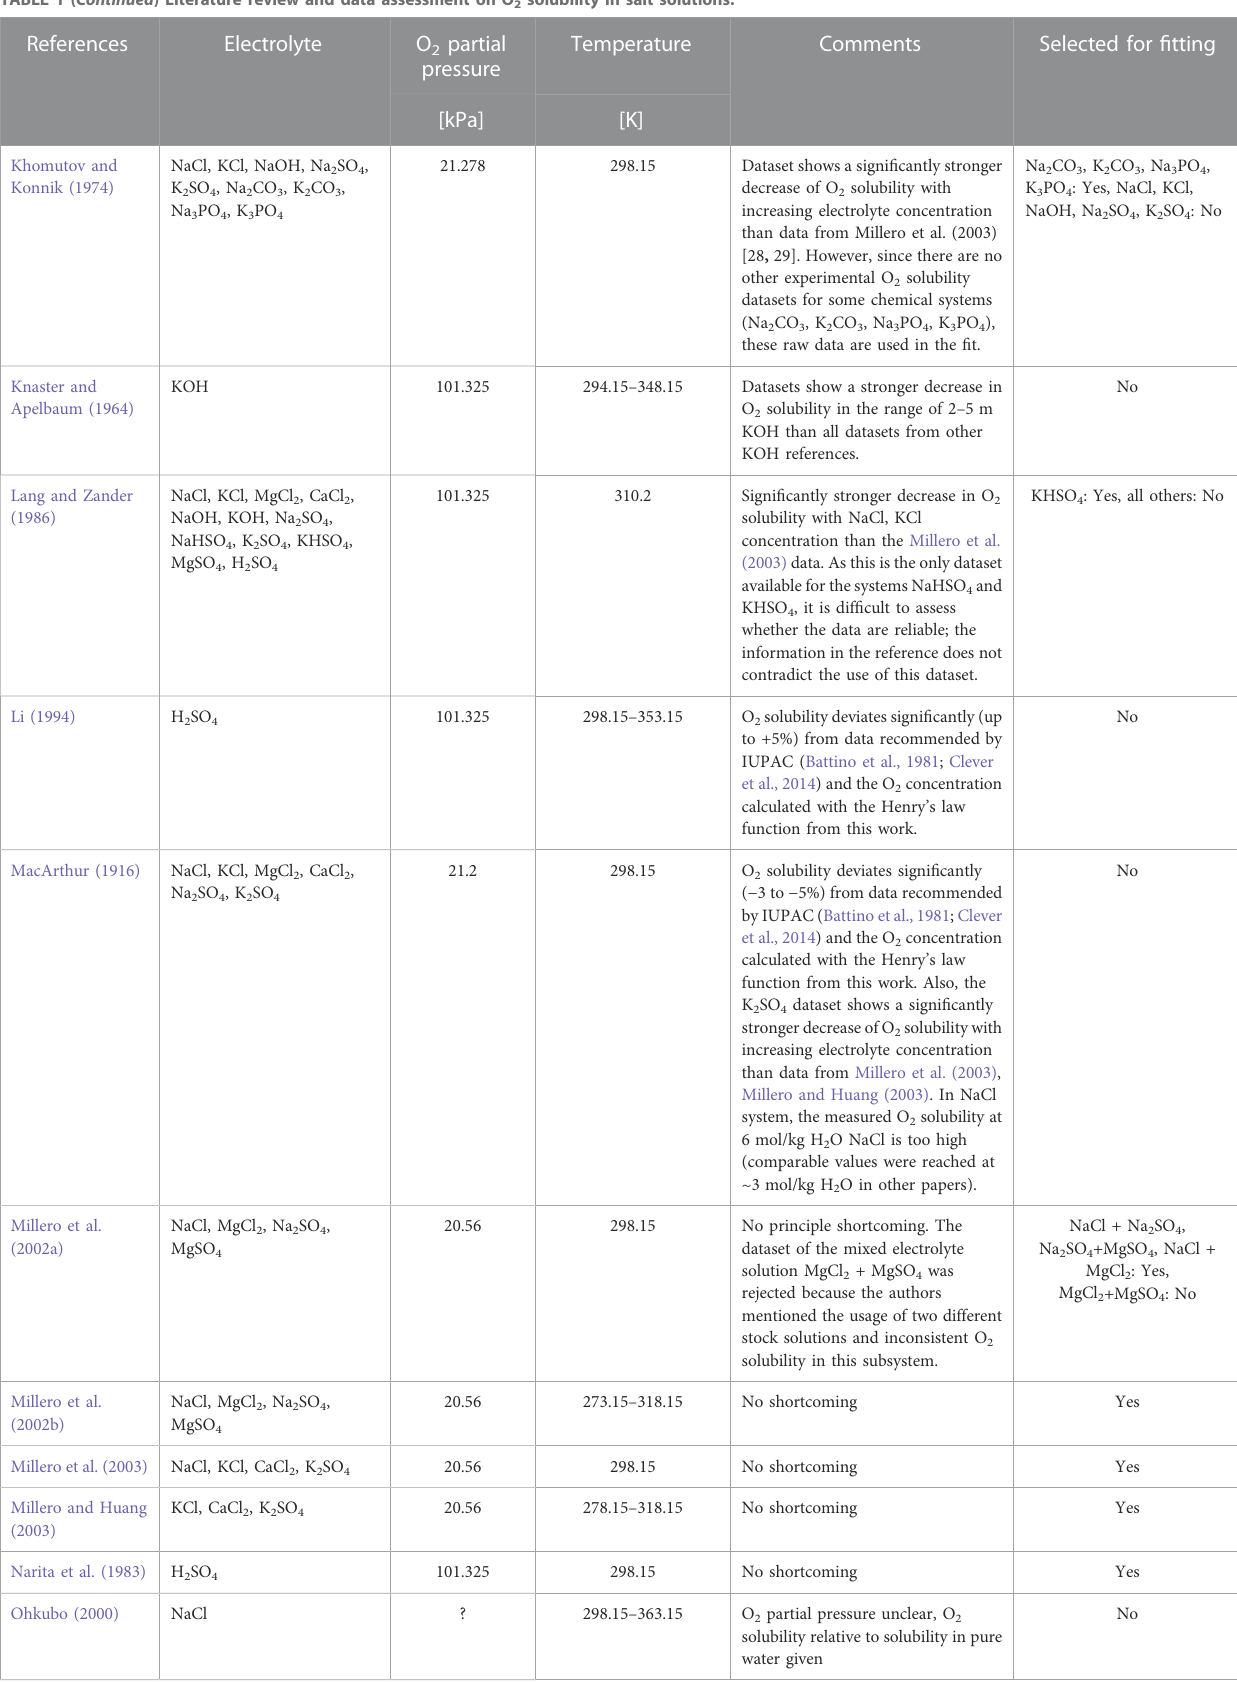
KOH than all datasets from other KOH